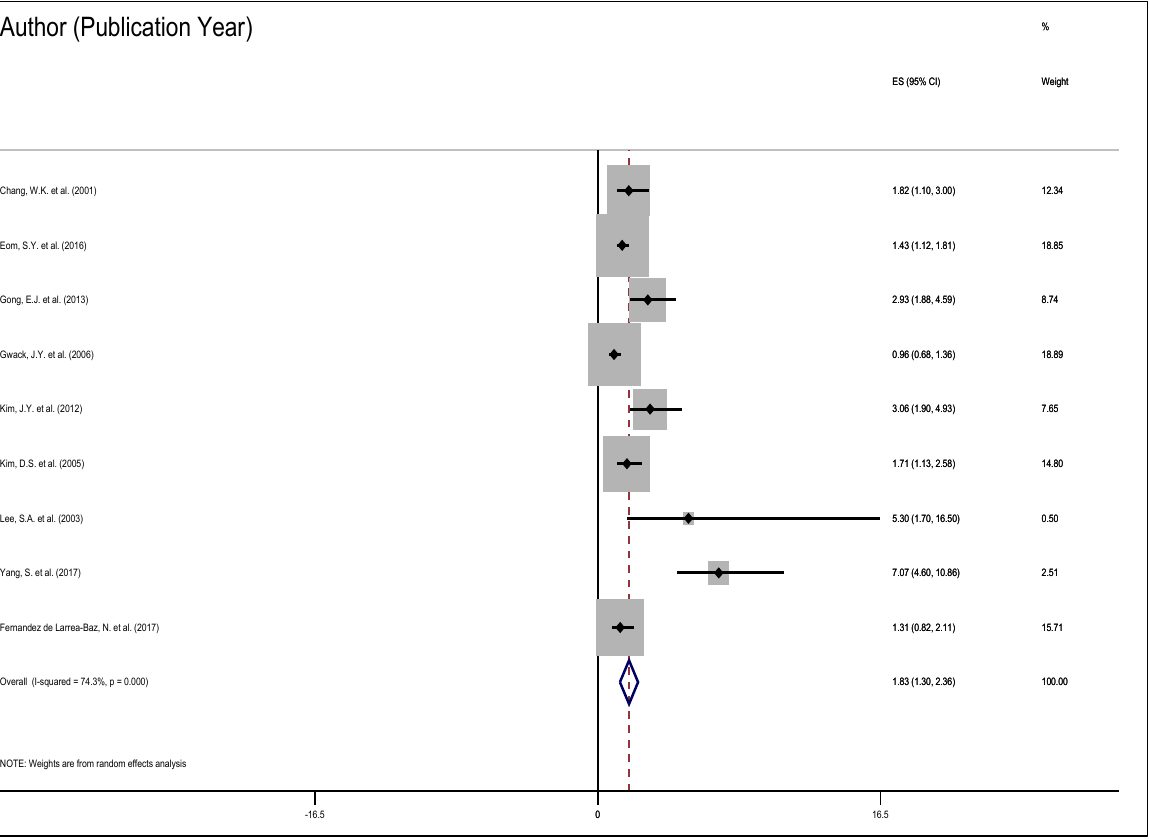
Figure 3. The correlation between H. pylori and gastric carcinoma adjusted for confoundings in a multivariable or multilevel analysis. The diamond illustrates the common effect sizes (CES) as the parameter estimate in the summary of the individual studies that constituted the CES. The dots represent the individual effect sizes, while the right and the left bars illustrate the 95% upper and lower limits, respectively.